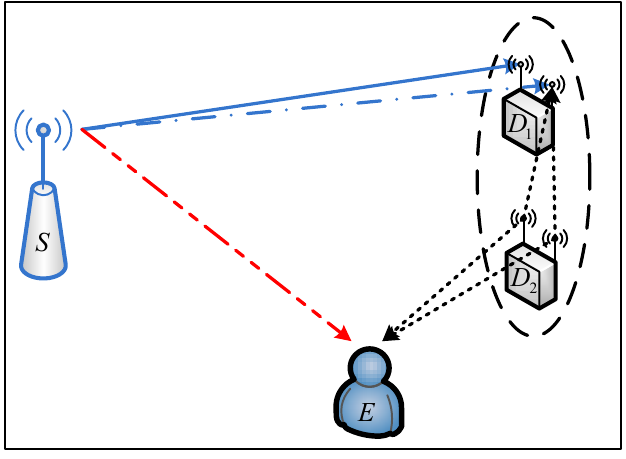
Figure 1. System